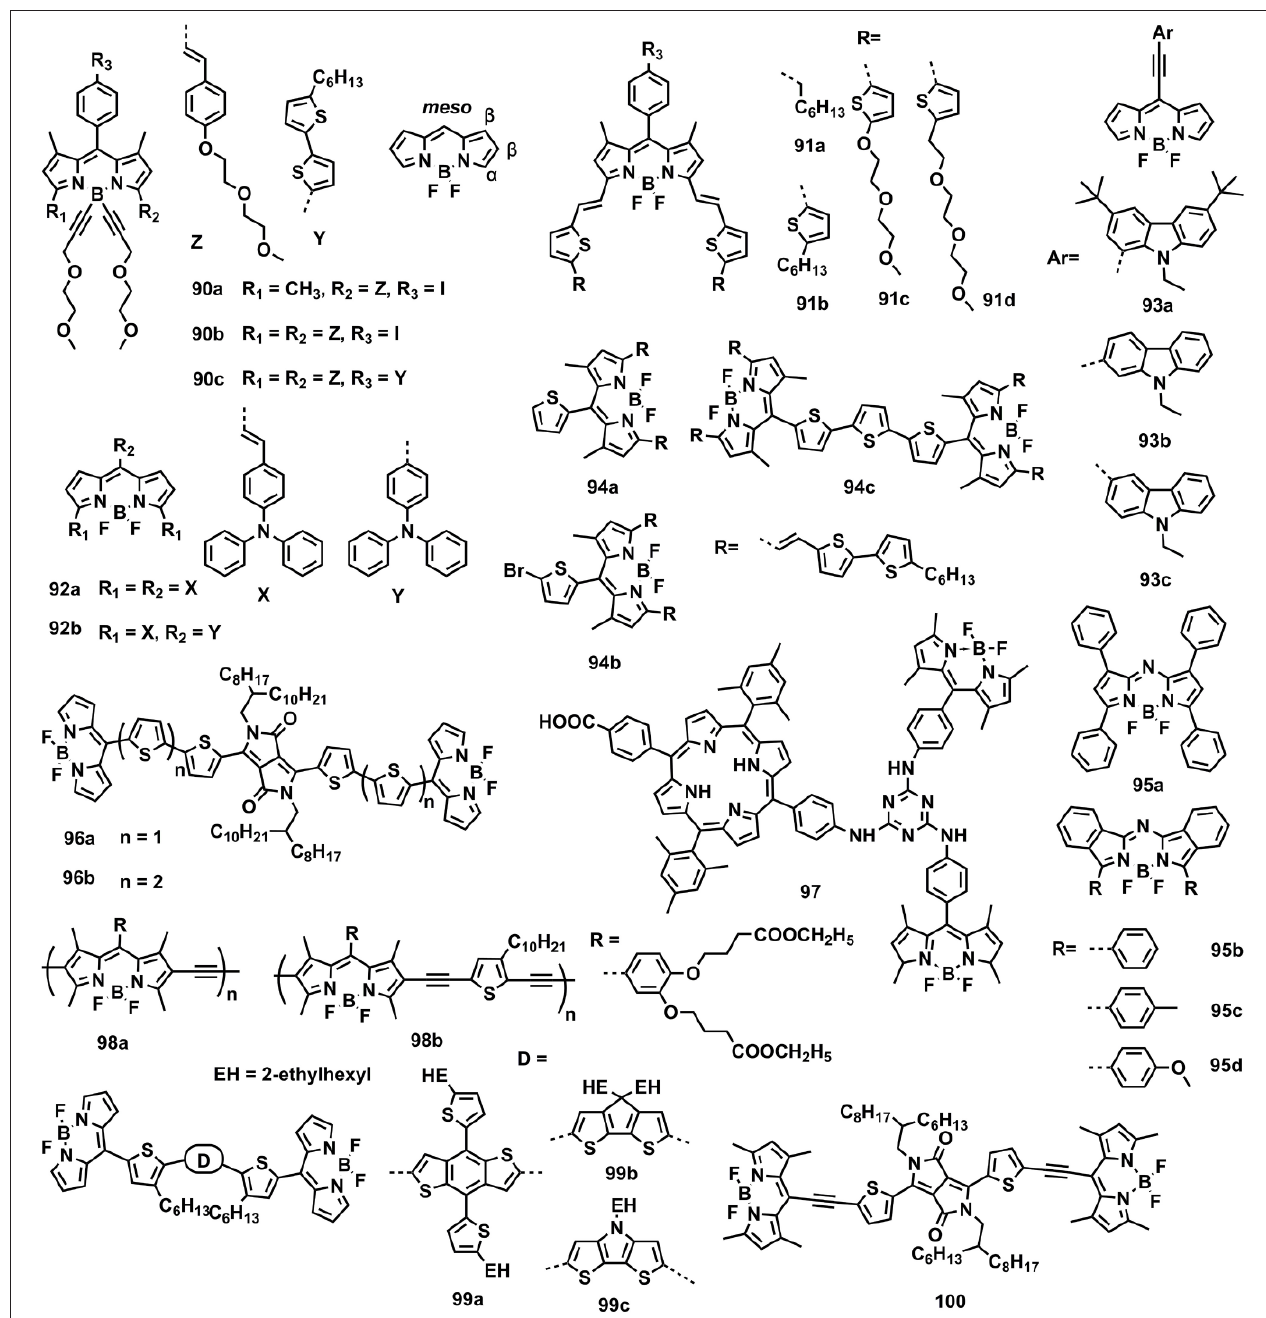
FIGURE 14 | Molecular structures of BODIPY-based photovoltaic